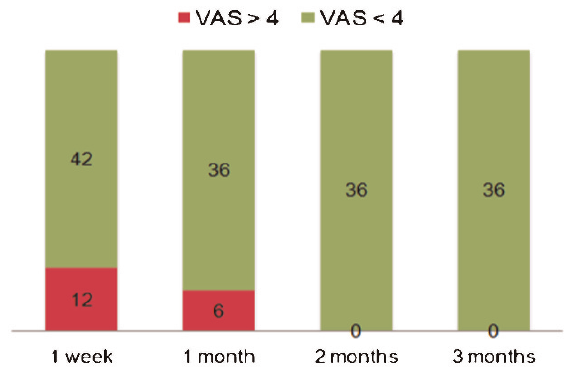
Figure 3 - Patient distribution at each evaluation time, according to their VAS scores